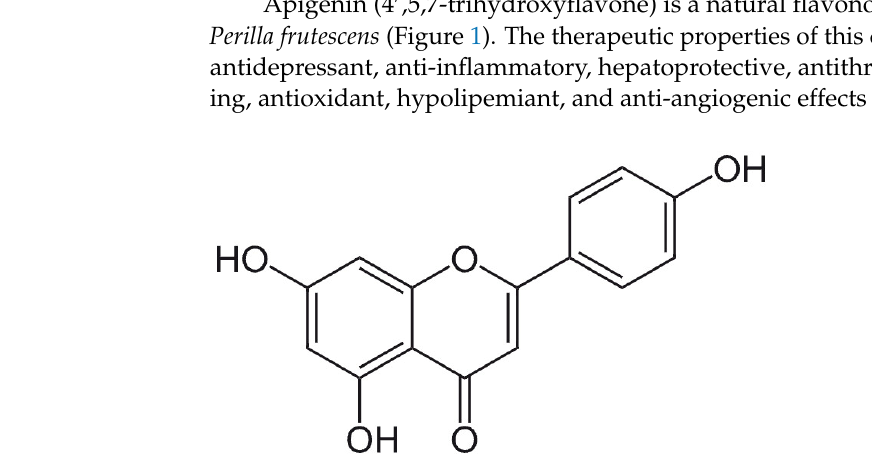
Table legend: AE—aqueous extract; RA—rosmarinic acid; OVA—ovalbumin; PCA—passive cutaneous anaphy- laxis; LPS—Lipopolysaccharides; TNF—tumor necrosis factor; IL—interleukin; EPCR—endothelial protein C receptor; LDL—low-density lipoprotein; NO—nitric oxide.